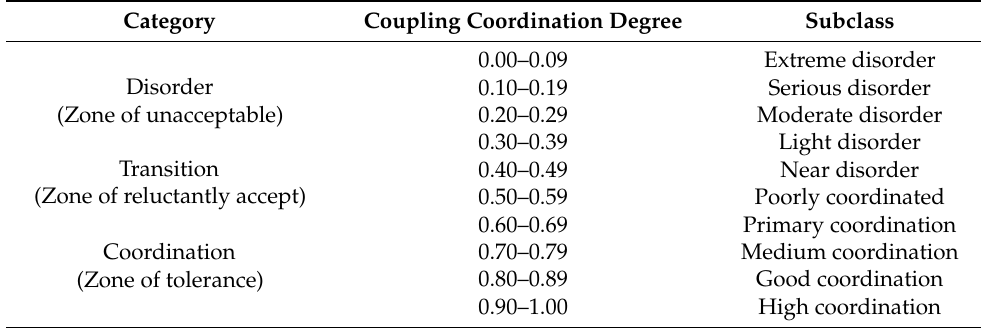
Table 2. Classification of coupling coordination degree.